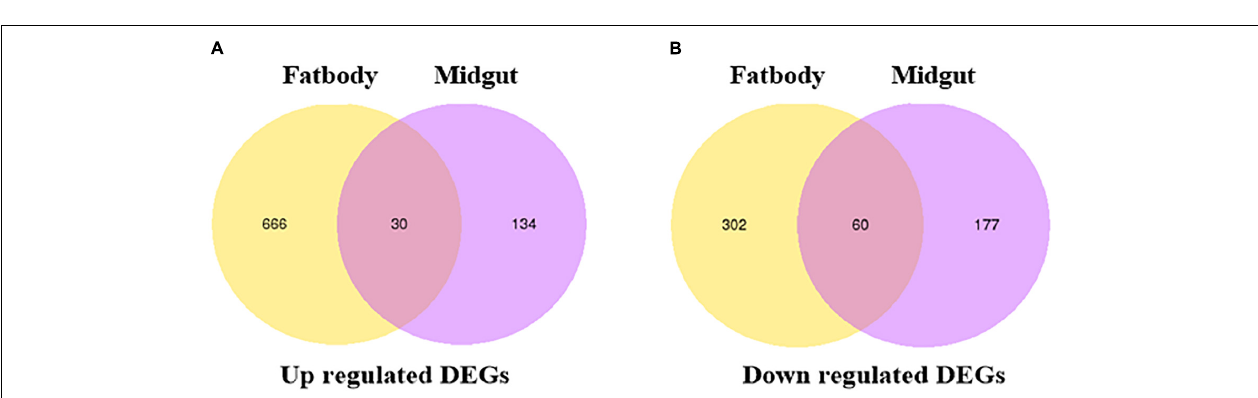
FIGURE 3 | Venn diagram illustrating the differentially expressed genes. (A) Venn diagram of upregulated DEGs in the fat bodies and midguts of S. litura subjected to tomatine treatment. (B) Venn diagram of downregulated DEGs in the fat bodies and midguts of S. litura subjected to tomatine treatment. The q -values in multiple tests were adjusted to control the false discovery rate (FDR). We used “fold changes ≥ 1 and q < 0.005” as the threshold to assess differentially expressed genes between the TOM treatment and control groups.